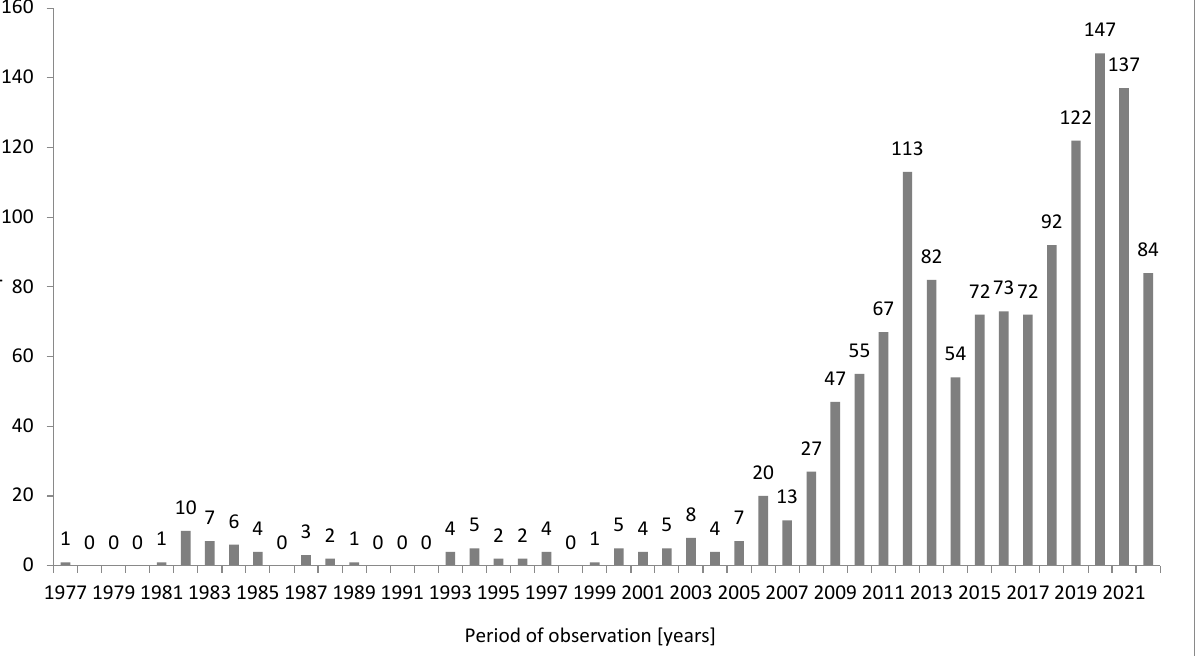
Figure 4. Cooperation between countries.